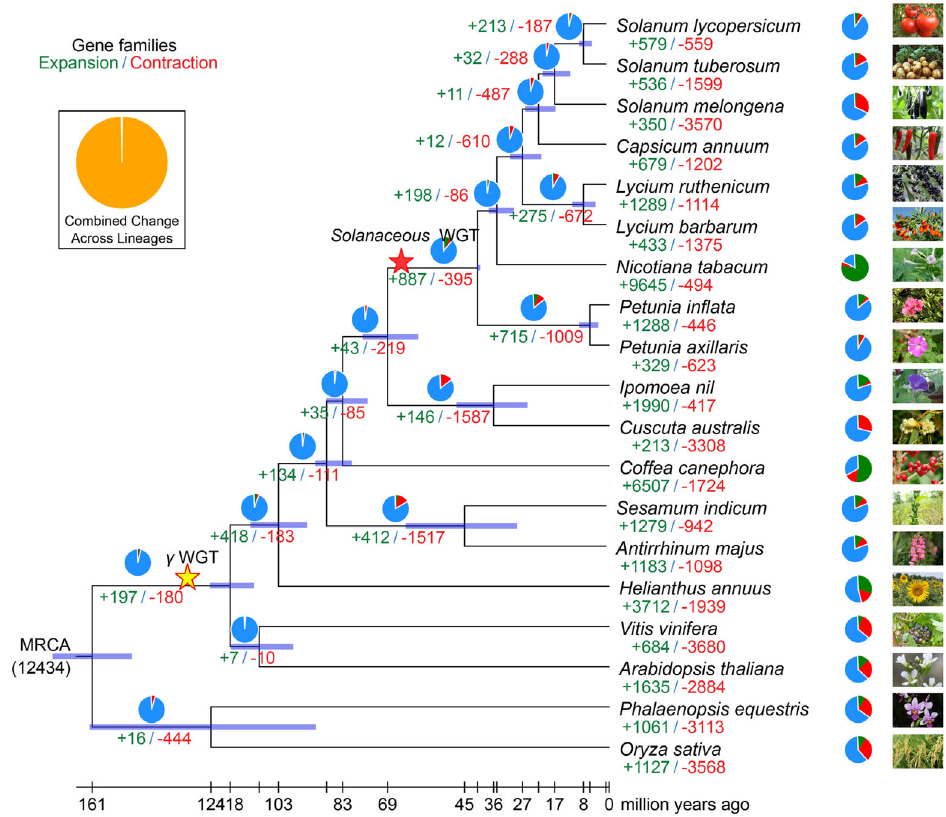
Fig. 1 Phylogenetic tree showing divergence times and the evolution of gene family size. The phylogenetic tree shows the topology and divergence times for 19 plant species. As expected, as a genus of the family Solanaceae, Petunia is sister to other genera; Lycium is sister to Capsicum and Solanum , indicating that woody Lycium evolved from an herb. In general, the estimated Solanaceae divergence times are in agreement with recent broad-scale Solanaceae phylogenies 5 . Divergence times are represented by light blue bars at internodes; the range of these bars indicates the 95% con fi dence interval of the divergence time. Numbers at branches represent the expansion and contraction of gene families (see “ Methods ” ). MRCA most recent common ancestor. The number in parentheses is the number of gene families in the MRCA as estimated by CAFÉ 16 . The yellow pentagram means the gamma WGT shared by eudicot plants, which occurred ~130 Mya 67 . The red pentagram means the Solanaceous shared WGT, which was estimated at an average of 69 Mya (Supplementary Table